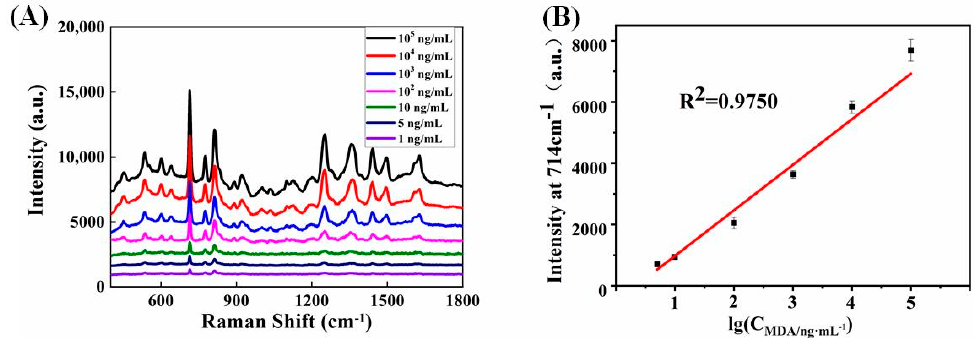
Figure 10. ( A ) Sandwich-structure-based SERS spectra of MDA with different concentrations. ( B ) Calibration plot based on Raman intensity at 714 cm − 1 .